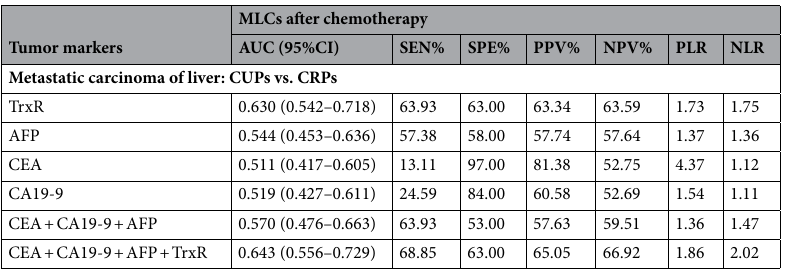
Table 3. Assessment of therapeutic efficiency using TrxR, AFP, CA19-9, CEA and their combinations after chemotherapy in MLC patients. SPE: specificity; SEN: sensitivity; NPV: negative predictive value; PPV: positive predictive value;NLR: negative likelihood ratio. PLR: positive likelihood ratio; the diagnosic threshold of TrxR activity level was 8.285 U/mL in MLC